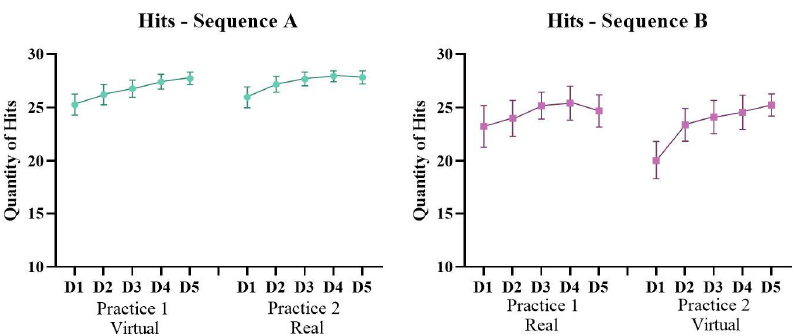
Figure 5. Representation of mean and standard error of the quantity of Hits of both Sequences (A: virtual → real and B: real → virtual) during the 10 days of intervention (D1–D5: Days of intervention).